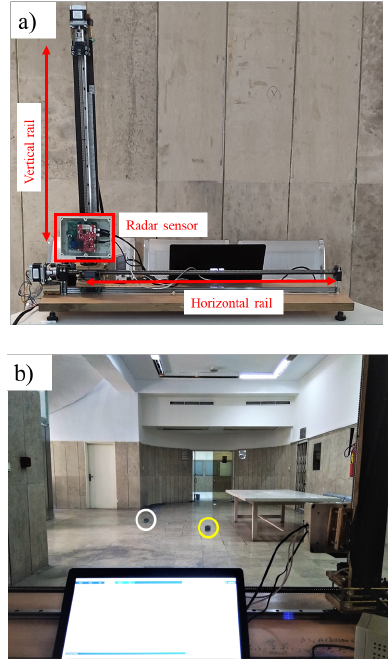
Figure 2. Measurement setup: (a) MIMO GBSAR system (b) Observing area. White and yellow circles denote fixed and moving corner reflectors,